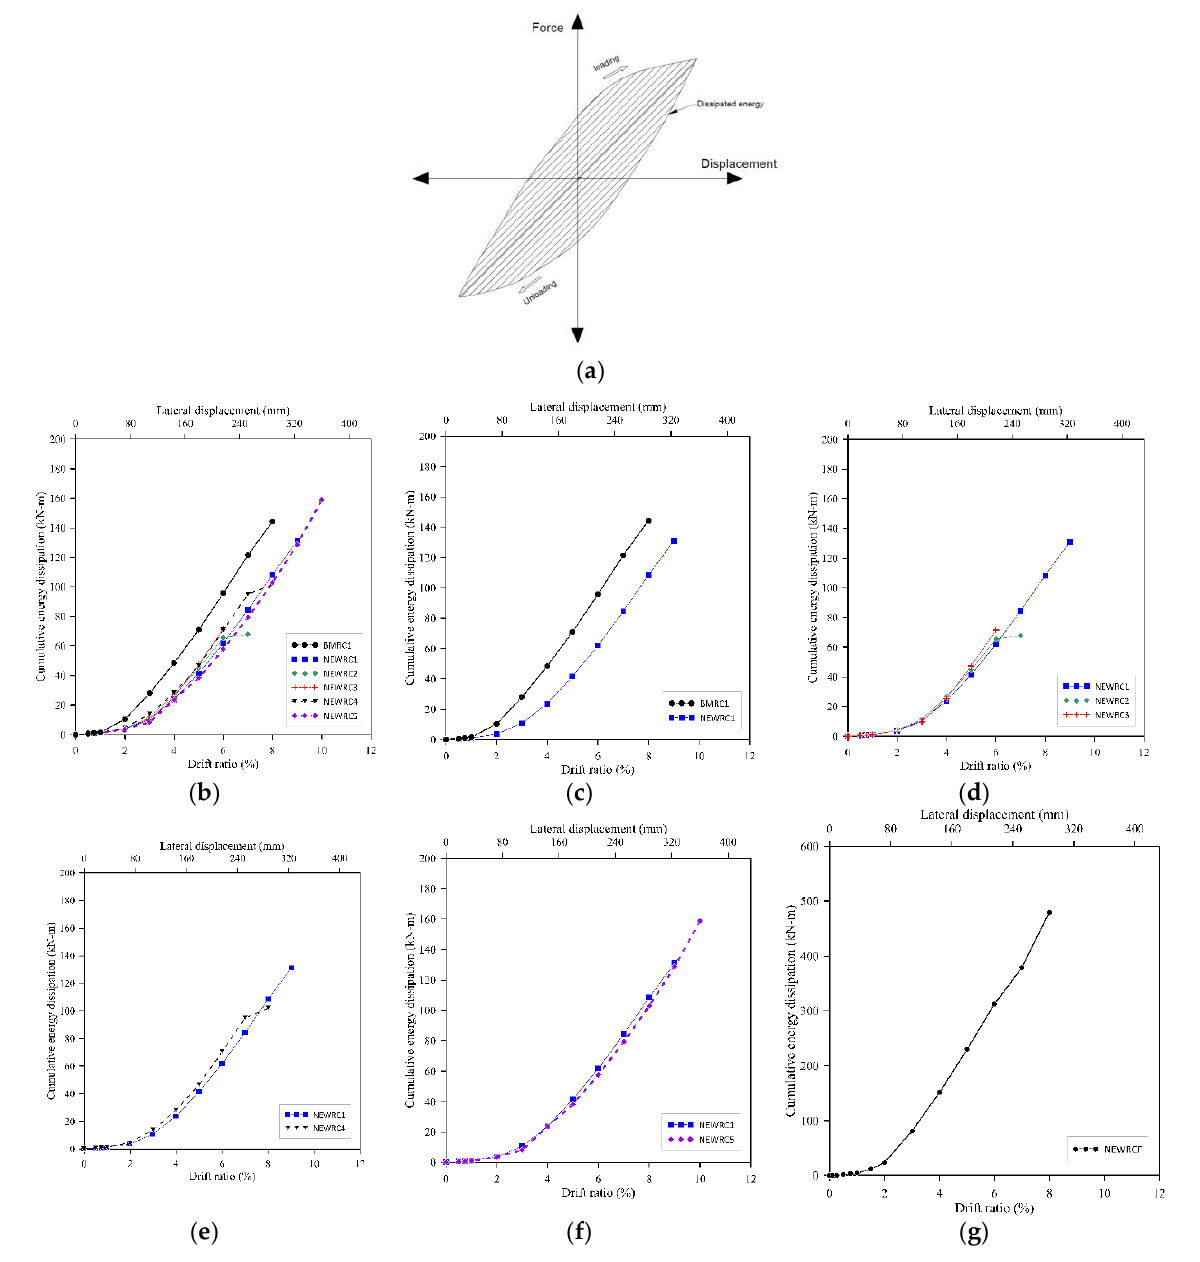
Figure 12. Cumulative energy dissipation: ( a ) Energy in the hysteretic loop; ( b ) BMRC1 and NEWRC1 – 5; ( c ) BMRC1 and NEWRC1; ( d ) NEWRC1, 2, and 3; ( e ) NEWRC1 and 4; ( f ) NEWRC1 and 5; ( g ) NEWRCF.